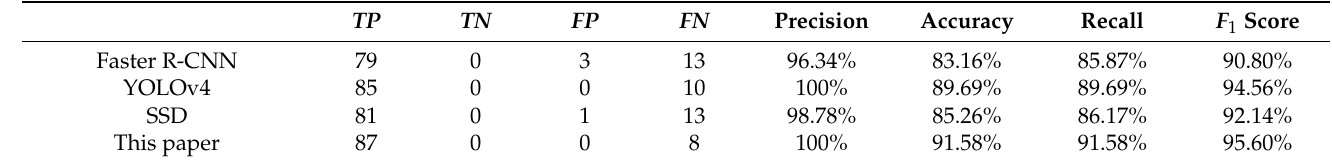
Table 10. Performance comparison of different object detection models.